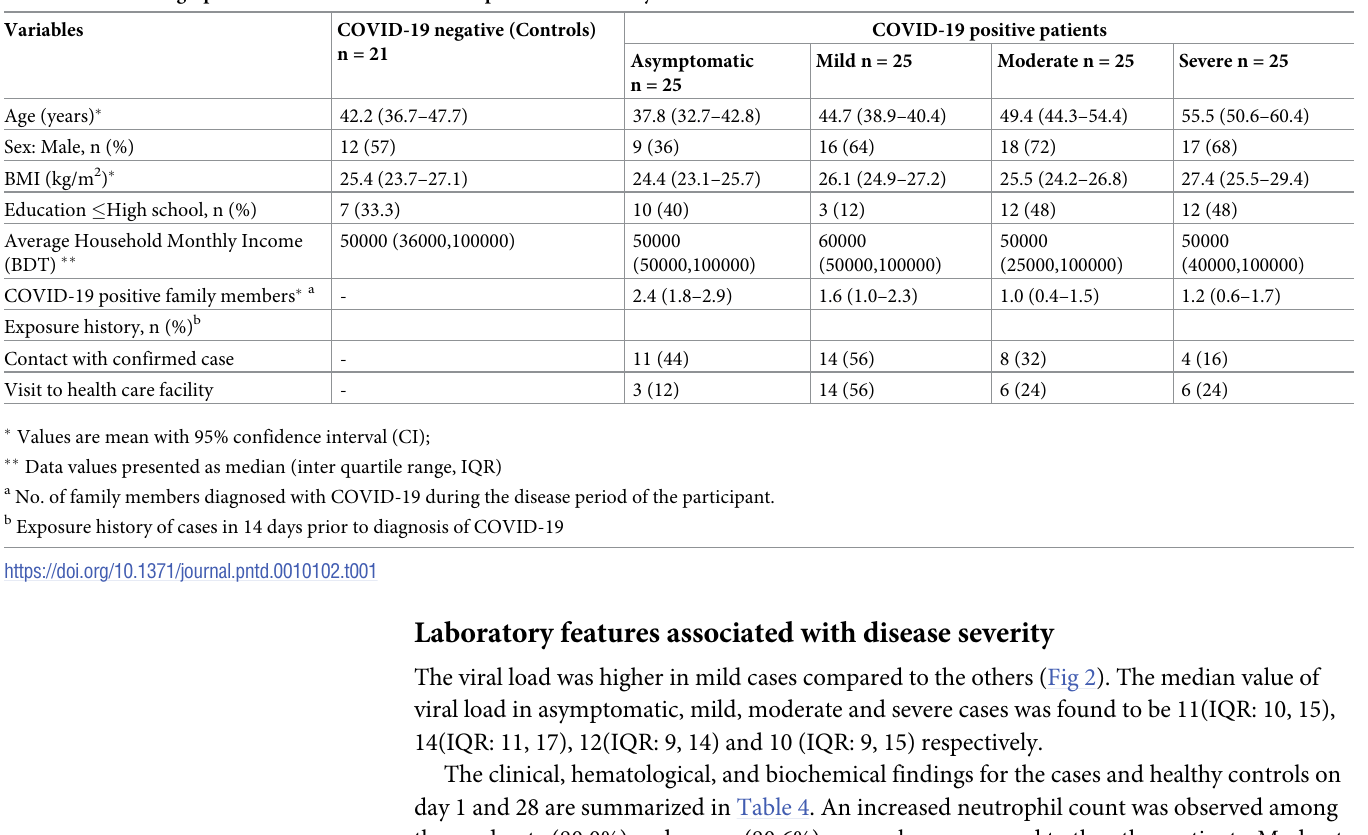
Table 1. Socio-demographic characteristics of COVID-19 patients and healthy